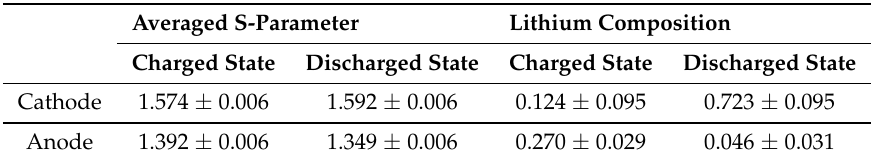
Figure 3. In the fresh cell: ( a ) The Compton scattering intensity distribution in the charged state. ( b ) The Compton scattering intensity distribution in the discharged state. ( c ) The S-parameter distribution in the charged state. ( d ) The S-parameter distribution in the discharged state. Table 1. The averaged S-parameter and corresponding lithium composition in the charged and discharged states in the fresh